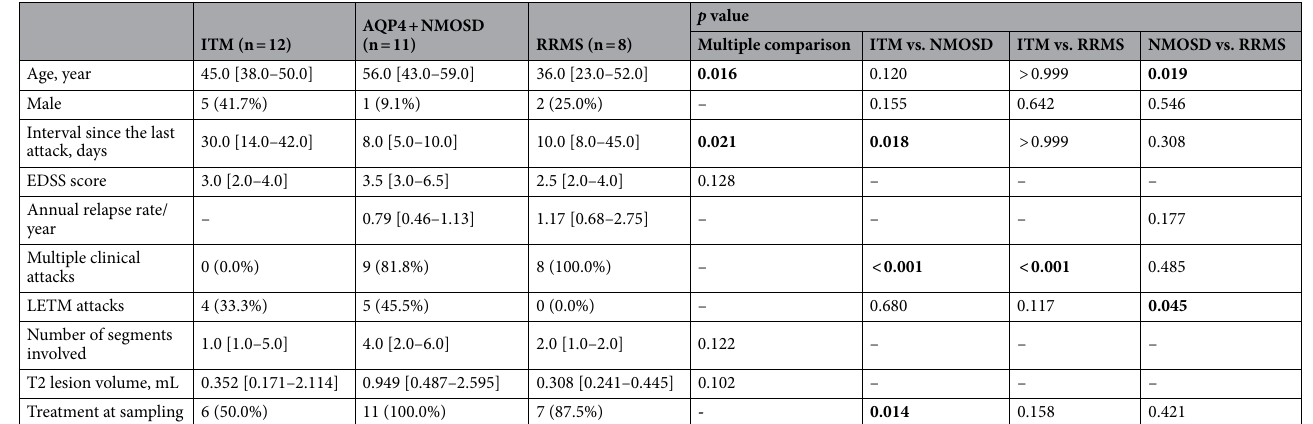
Table 3. Demographic and clinical features of patients with acute transverse myelitis attacks. All patients experienced an acute transverse myelitis attack within the last two months before blood sampling. Values represent medians with interquartile ranges or counts with percentages. Treatment includes disease-modifying drugs, corticosteroids, and immunosuppressants. p values with statistical significance ( p < 0.05) are presented in bold. ITM: idiopathic transverse myelitis; AQP4 + NMOSD: aquaporin-4 antibody-positive neuromyelitis optica spectrum disorder; RRMS: relapsing–remitting multiple sclerosis; EDSS: Expanded Disability Status Scale; LETM: longitudinally extended transverse myelitis.